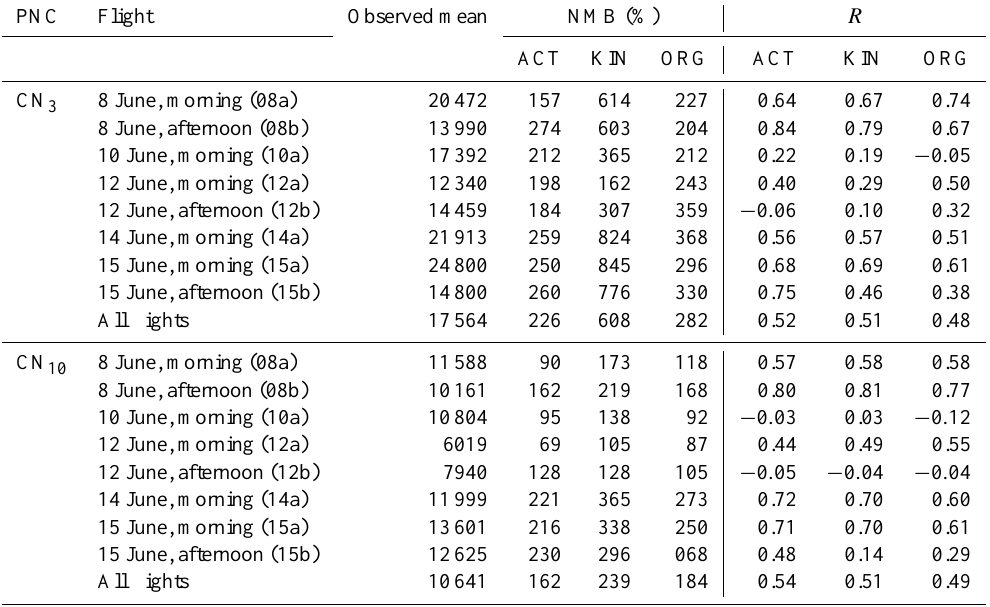
Table 4. Observed mean and simulation summary statistics for aerosol number concentrations for particle diameters ≥ 3nm (CN 3 ) and CN 10 . The observed mean, normalized mean bias (NMB) and correlation coefficient ( R ) are calculated between simulated and observed number concentration collected during the CARES G-1 aircraft flights.